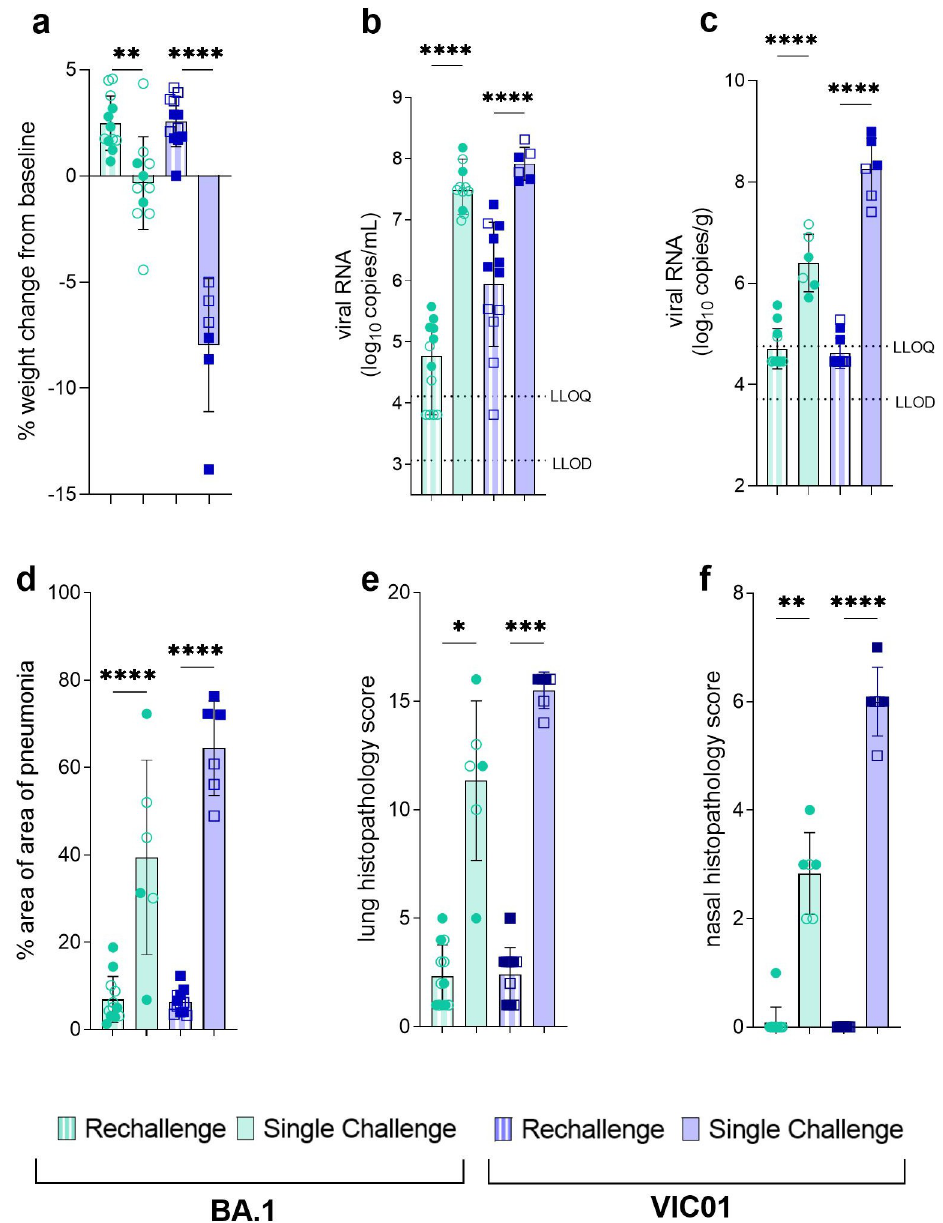
Fig 6. BA.1 offers sufficient discriminatory power for evaluation of BA.1-specific countermeasures ( a ) At 7 days post infection there was a significant difference in percent weight change between BA.1 single infection and rechallenge hamsters (P = 0.0021) and VIC01 single infection and rechallenge hamsters (P < 0.0001). Statistical analysis between groups was carried out using one-way ANOVA. ( b ) Total viral RNA in throat swabs at 2 days post infection was quantified by RT-qPCR. Bars show group mean and error bars show standard deviation. The dashed horizontal lines show the lower limit of quantification (LLOQ) and the lower limit of detection (LLOD). A significant difference was seen between BA.1 single infection and rechallenge (P < 0.0001) and between VIC01 single infection and rechallenge (P = < 0.0001) groups. Statistical analysis between groups was carried out using one-way ANOVA. ( c ) Total viral RNA in the lung at 7 days post infection was quantified by RT-qPCR. Bars show group mean and error bars show standard deviation. The dashed horizontal lines show the lower limit of quantification (LLOQ) and the lower limit of detection (LLOD). Significantly less virus was found in the lungs of BA.1 and VIC01 rechallenge animals (both < 0.0001) compared to single infection. Statistical analysis between groups was carried out using one-way ANOVA. ( d ) Percentage area of pneumonia was significantly less in both rechallenge groups compared to single infection groups (both P < 0.0001). Statistical analysis between groups was carried out using one-way ANOVA. ( e ) Lung and ( f ) nasal cavity scores were significantly reduced in BA.1 (P = 0.0144, P = 0.0081) and VIC01 (P =